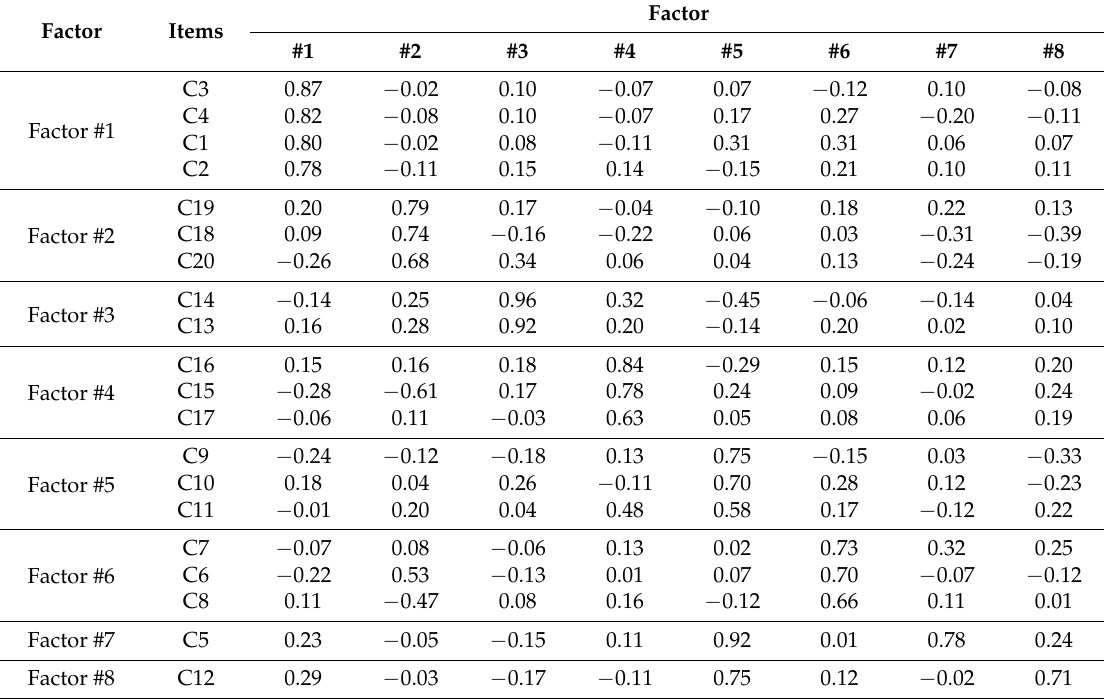
Table 3. Rotation component matrix of job stress